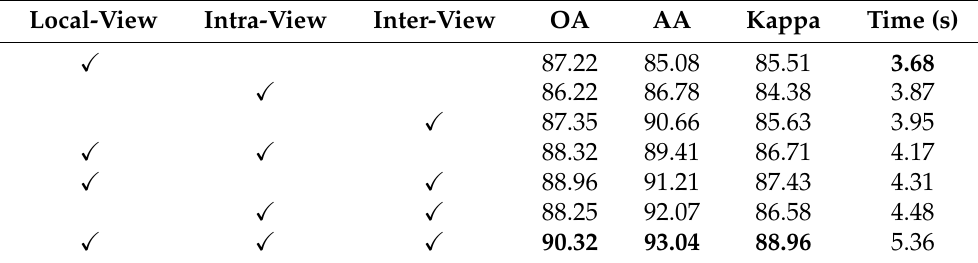
Table 5. Classification performance of three different views. The bold denotes the best classification